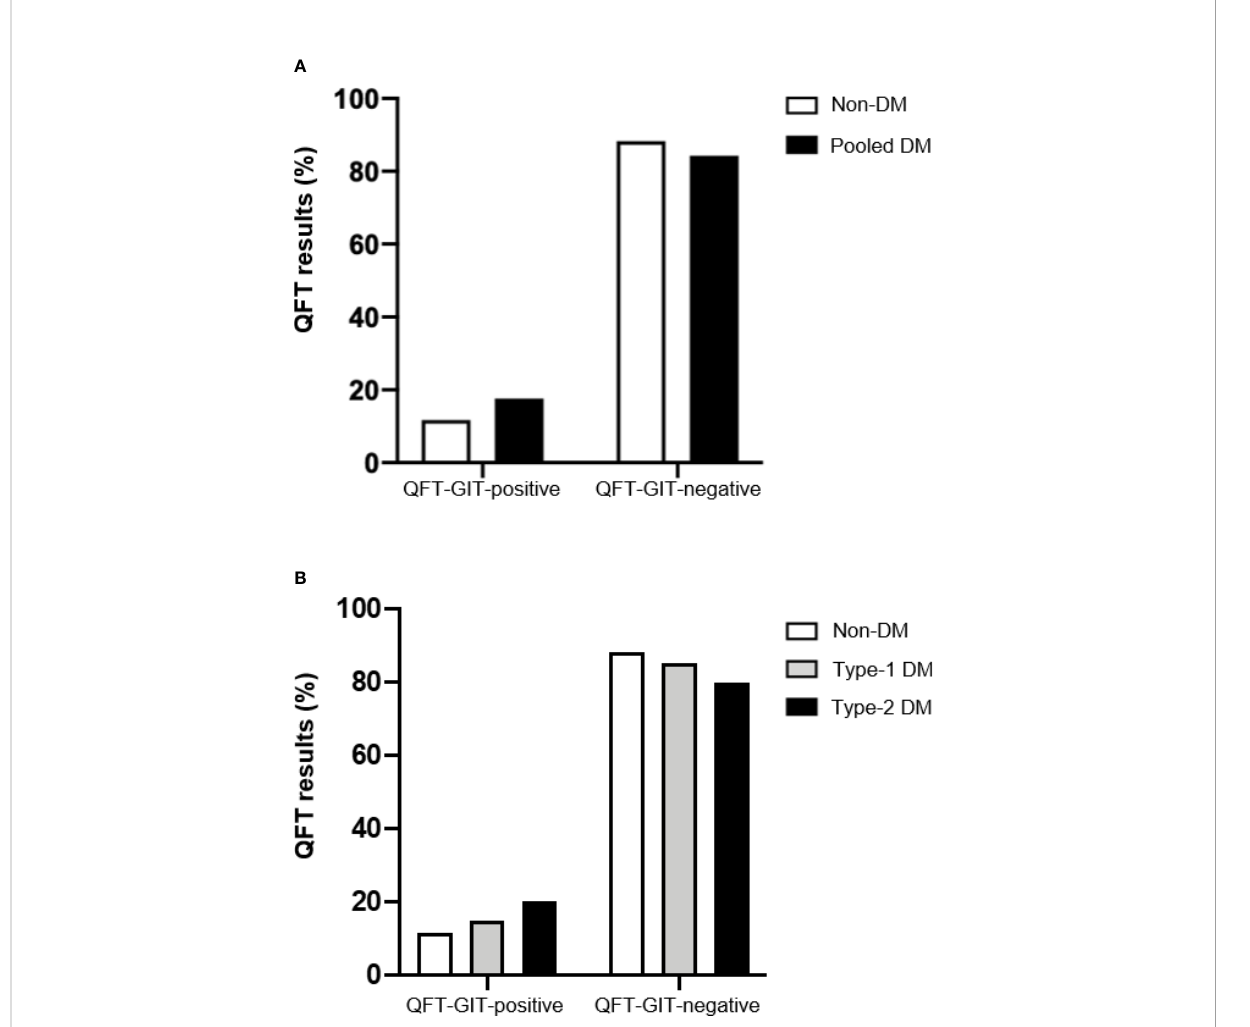
FIGURE 2 QFT-GIT results between non-diabetic and diabetic patients. The QuantiFERON-TB Gold in Tube results in subjects with Diabetes Mellitus or not were provided by the stimulation of whole blood with Mtb-speci fi c antigens (ESAT-6, CFP-10 and TB7.7) or mitogen (positive control). (A) QFT-GIT results (%) from non-DM and pooled MD (T1D and T2D patients) were compared. (B) QFT-GIT results (%) from non-DM, T1D and T2D were compared. DM, Diabetes Mellitus; T1D, type-1 DM; T2D, type-2